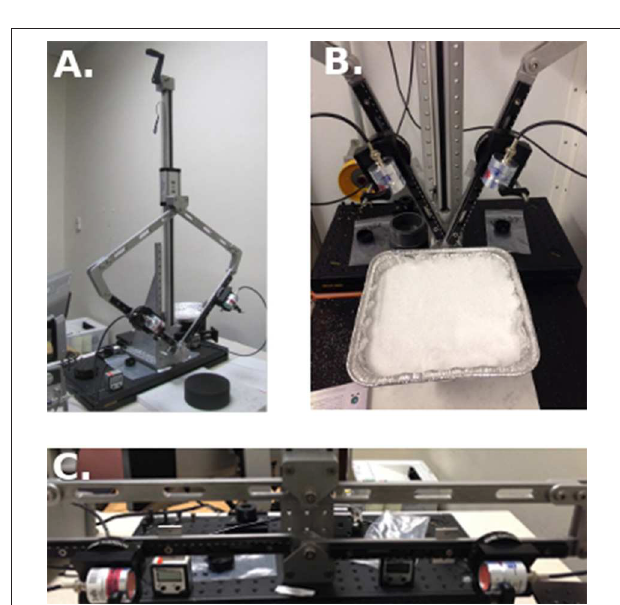
FIGURE 3 | (A) Ultrasonic transducer positioning rig following the methods of Pialucha and Cawley (1994). (B) Photo of ultrasonic transducer positioning rig being used to record reflections in a cold room. (C) Ultrasonic transducer positioning rig with transducers in horizontal position.